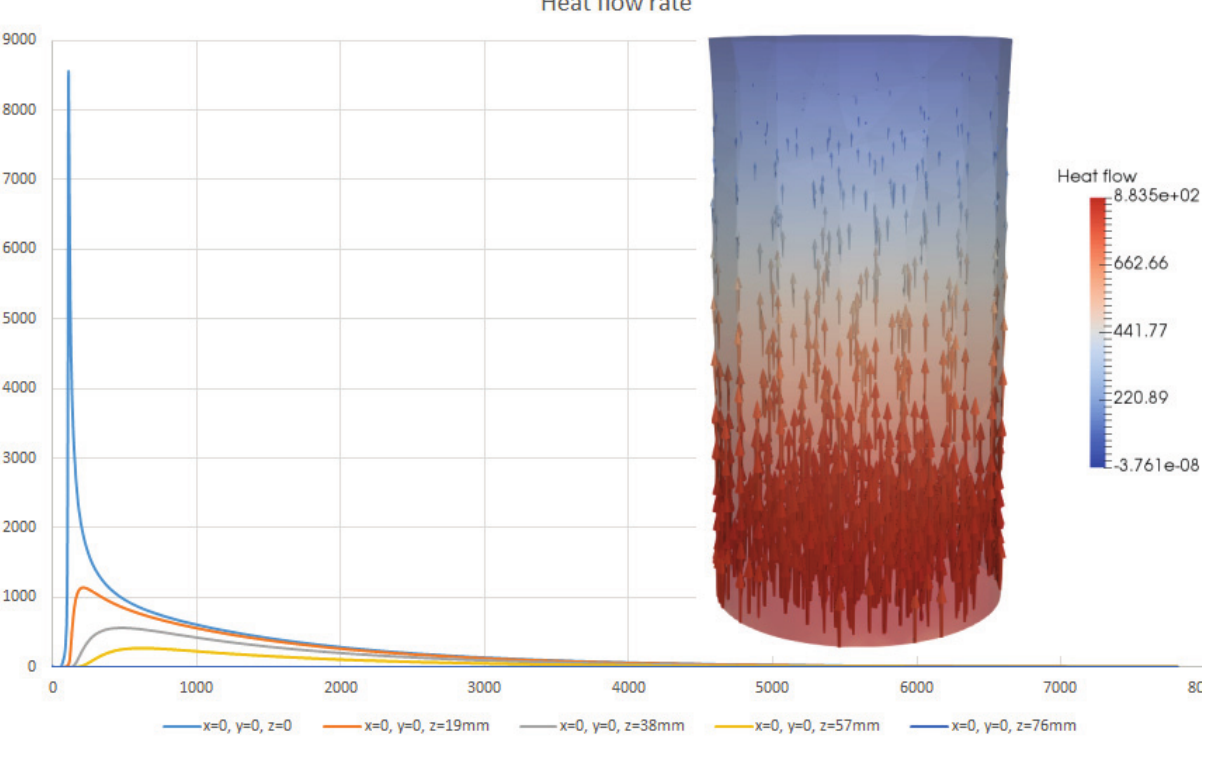
Fig. 4. Amount of heat flowing through the medium at points: a) 0,0,0; b) 0, 0, 19 mm; c) 0, 0, 38 mm; d) 0, 0, 57 mm; e) 0, 0, 76